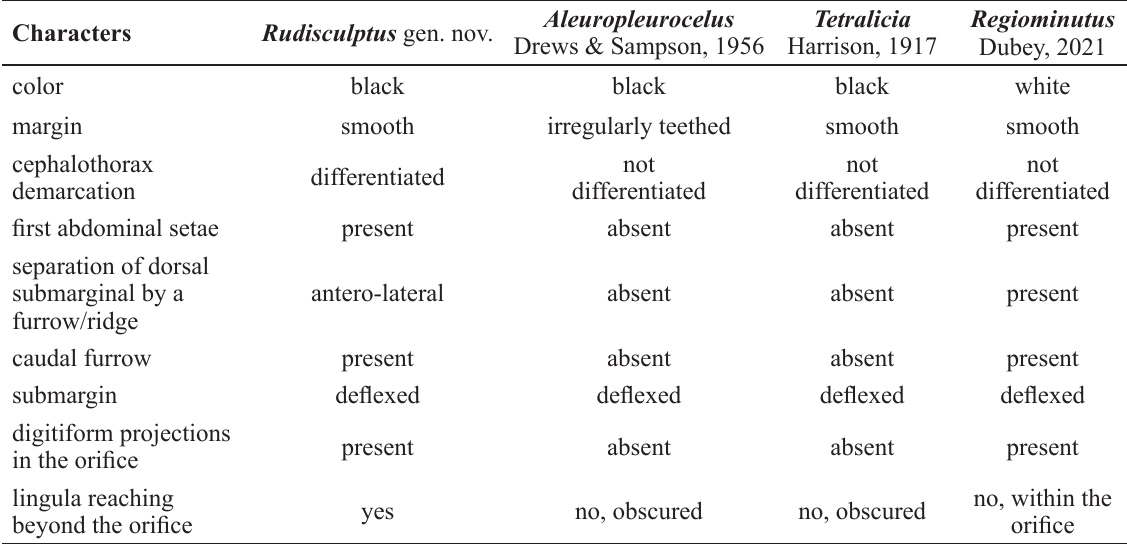
Table 1. Comparison of puparial characters of Rudisculptus gen. nov. with related genera; updated from Dubey